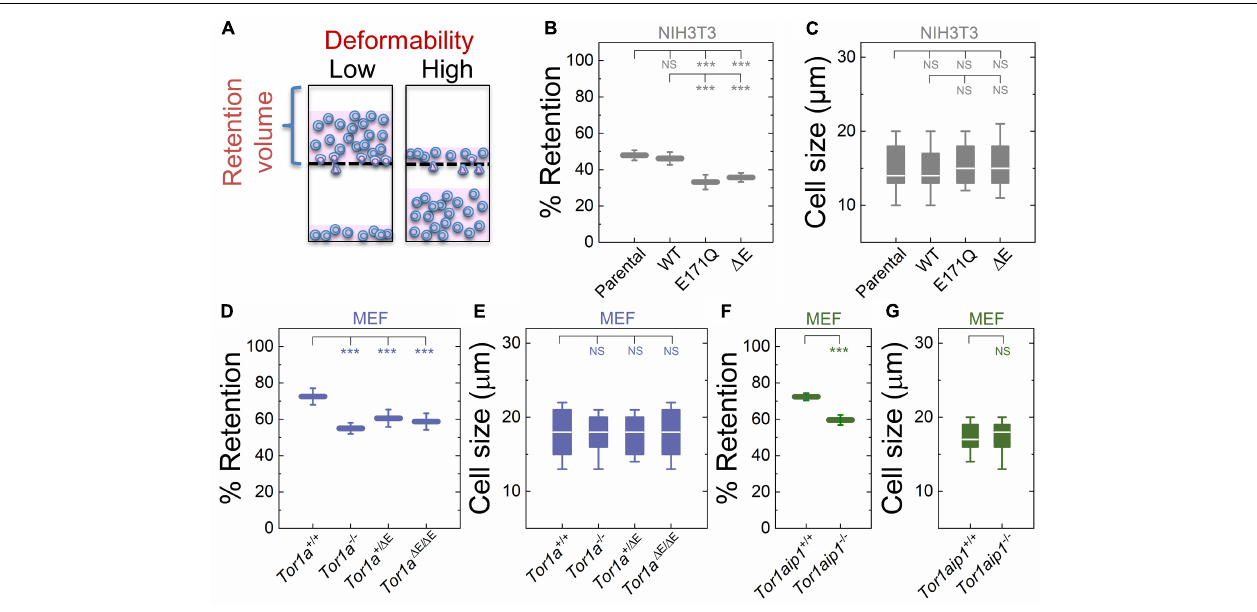
FIGURE 1 | Fibroblasts lacking functional torsinA or LAP1 have increased deformability relative to controls. (A) Schematic illustration of PMF. Less deformable cells tend to occlude pores, thereby blocking fluid flow and resulting in an increased volume of fluid that is retained above the membrane. The retained fluid volume relative to the initial loaded volume is % retention. (B) PMF measurements of NIH3T3 fibroblasts expressing the indicated SS-EGFP-tagged torsinA constructs. (D,F) PMF measurements of the indicated MEF lines. PMF conditions: 10 µ m pore size, 2.1 kPa for 50 s. Each data point represents the mean ± standard deviation (SD). Statistical significance was determined using Student’s t -test. (C,E,G) Cell size data. Boxplots show 25 and 75th percentiles; line shows median; and whiskers denote 10 and 90th percentiles. All data were obtained from three independent experiments. Statistical significance was determined using Mann-Whitney U -test. ∗∗∗ p < 0.001; not significant (NS) p >